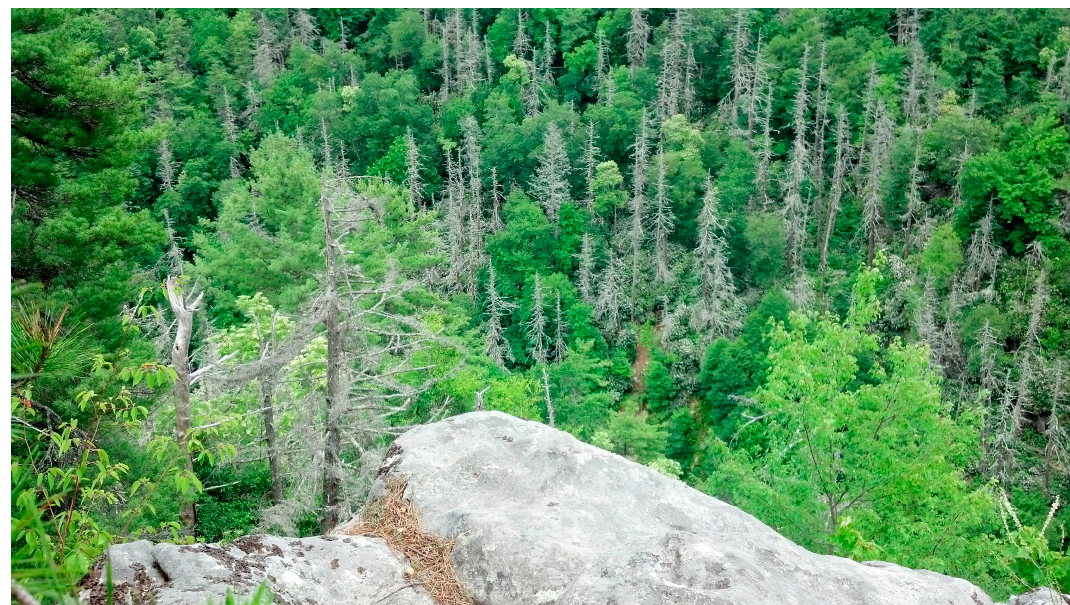
Figure 2. Photo of dead hemlocks taken from the western rim of the Linville Gorge on 10 July 2014. Early after mortality, the lichen-covered white branches show unique looks, often called “grey ghosts”. The recovery pattern of deciduous trees can also be seen in this photo taken by Steven P. Norman, US Forest Service.